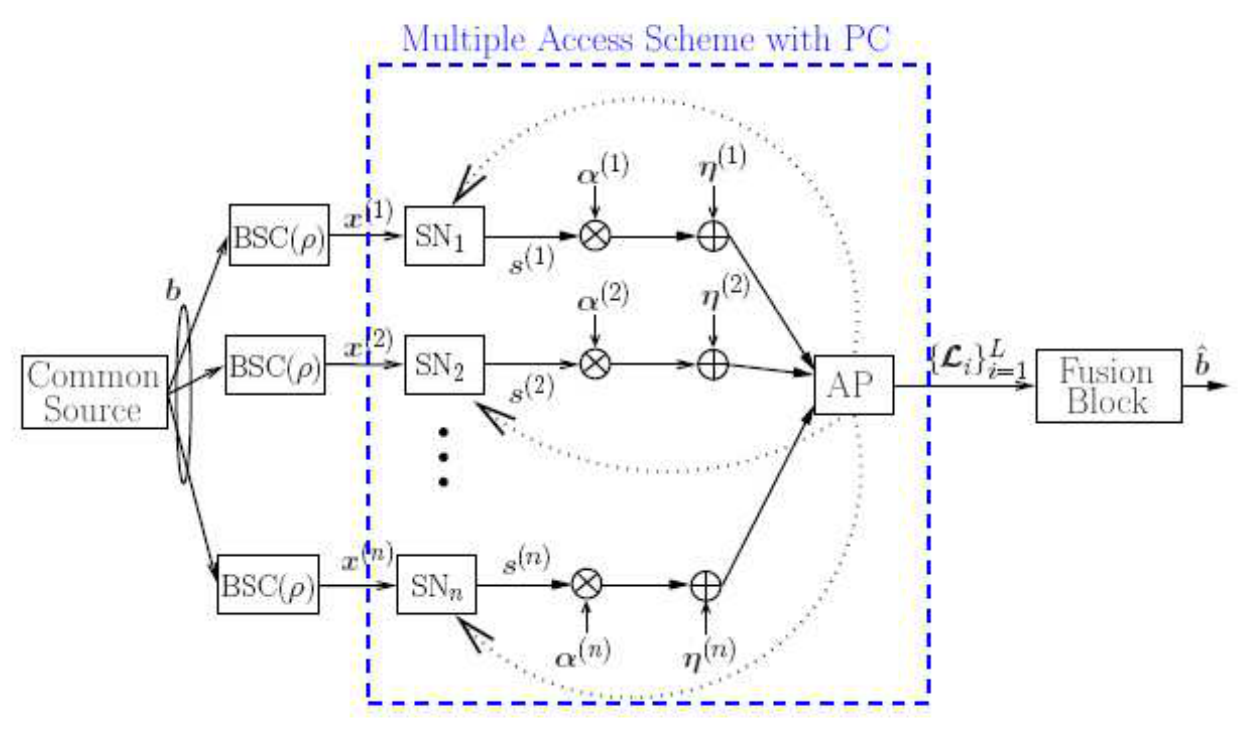
Figure 13. CEO scenario: multiple access scheme followed by